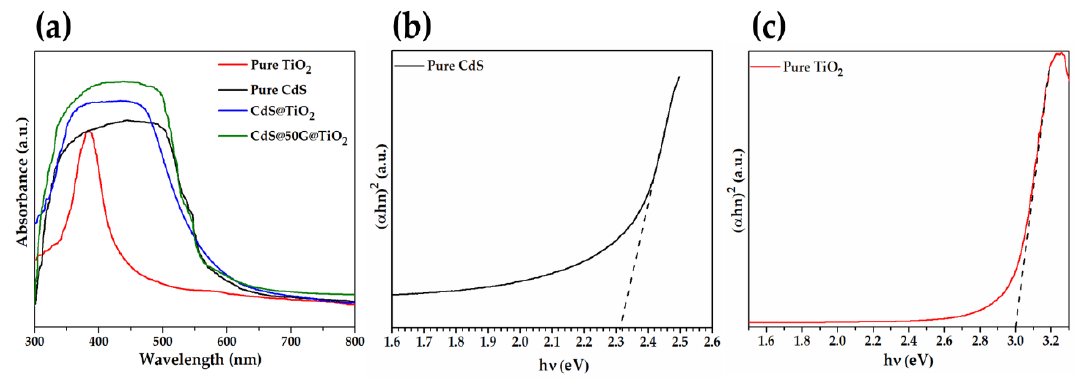
Figure 3. UV-vis DRS spectra of pure TiO 2 , pure CdS, CdS@TiO 2 and CdS@50G@TiO 2 ( a ), bandgap measurements by using Tauc plots of pure CdS ( b ) and pure TiO 2 ( c ).